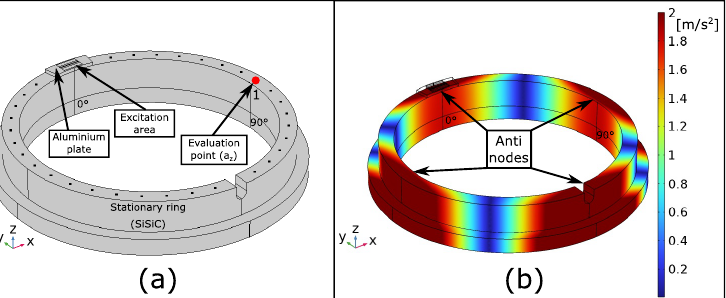
Figure 9. ( a ) Extended SiSiC ring model with attached aluminum plate including body loads, representing the EMAT and its excitation. ( b ) Simulated absolute acceleration in the z-direction. The simulated EMAT excitation is capable of exciting the second mode described in Section